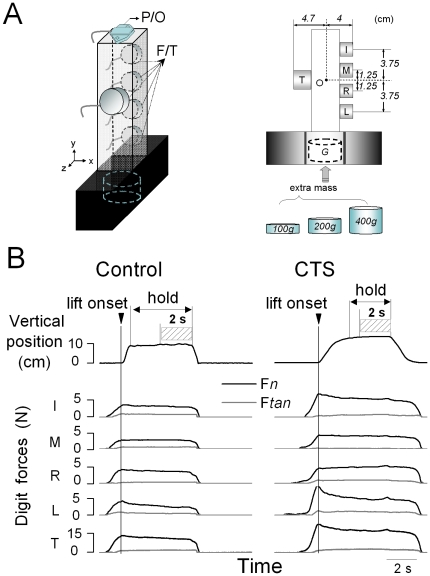
Experimental setup and variables.Panel A shows the grip device used for the experiments. Force/torque sensors (F/T) are mounted on both sides of the device to measure forces and moment of forces exerted by each digit (thumb, index, middle, ring, and little fingers: T, I, M, R, and L, respectively). A position/orientation (P/O) sensor was mounted on the top of the device to measure object kinematics. A mass (G: 100 g, 200 g, or 400 g) was inserted at the bottom of the grip device for each experimental condition. Dimensions are in cm. Panel B shows, from top to bottom, the time course of the object vertical position and digit normal and tangential forces (Fn and Ftan, respectively). Force traces are aligned with object lift onset (vertical line). Forces were analyzed at object lift onset and the last 2 seconds of object hold (striped area) used for analysis of Fn. Data are from one representative CTS patient (S3) and her matched control (right and left column, respectively) performing the task on the third trial (445 g condition).